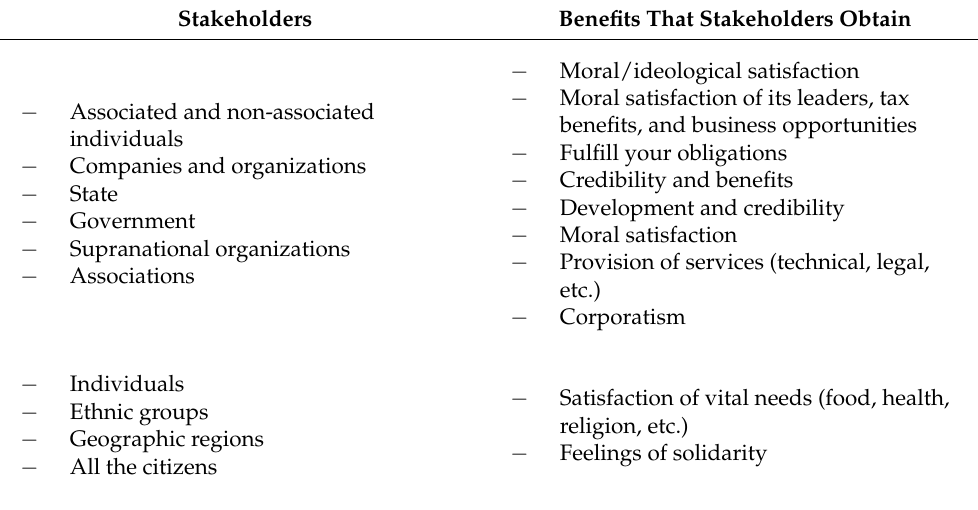
Table 1. The NGO markets